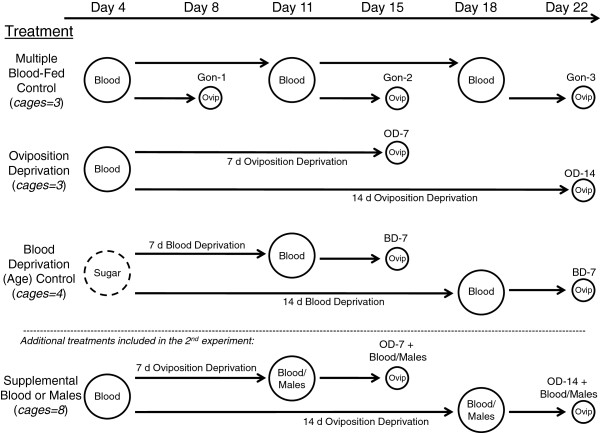
Schematic showing the basic experimental design with the time line above and treatments listed on the right. Large circles represent replicate cages (all set up on the same day with 100 females and 100 males each), with number of replicate cages per treatment in each experiment shown. Small circles represent individual oviposition tubes, where females were placed and provided water and filter-paper for oviposition (8 females per cage). In the design of the second experiment, two treatments, (shown below the dotted line) consisting of either a supplemental blood meal or supplemental males for insemination, were included in addition to those used in the first experiment (shown above the dotted line).